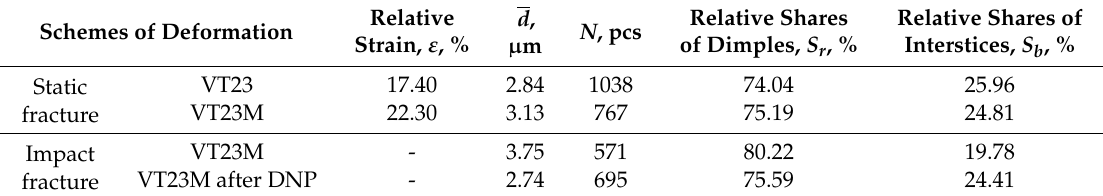
Table 3. Quantitative results of image analysis.